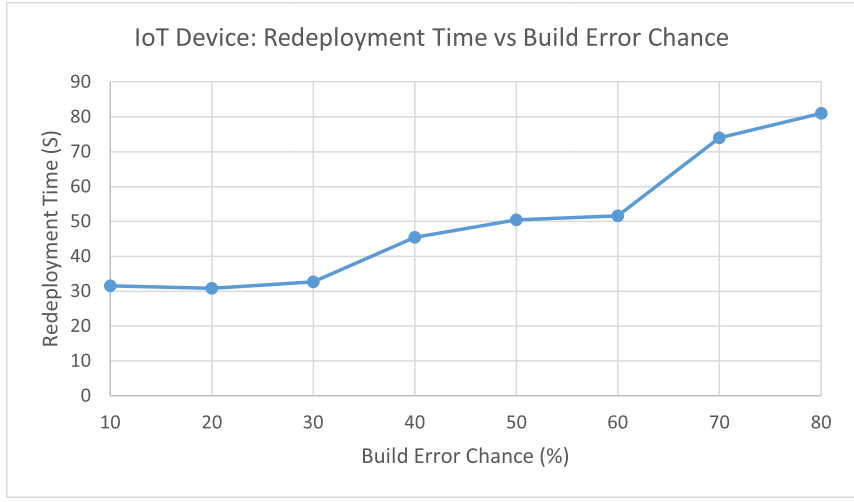
Figure 12. Redeployment Time vs. Build Error